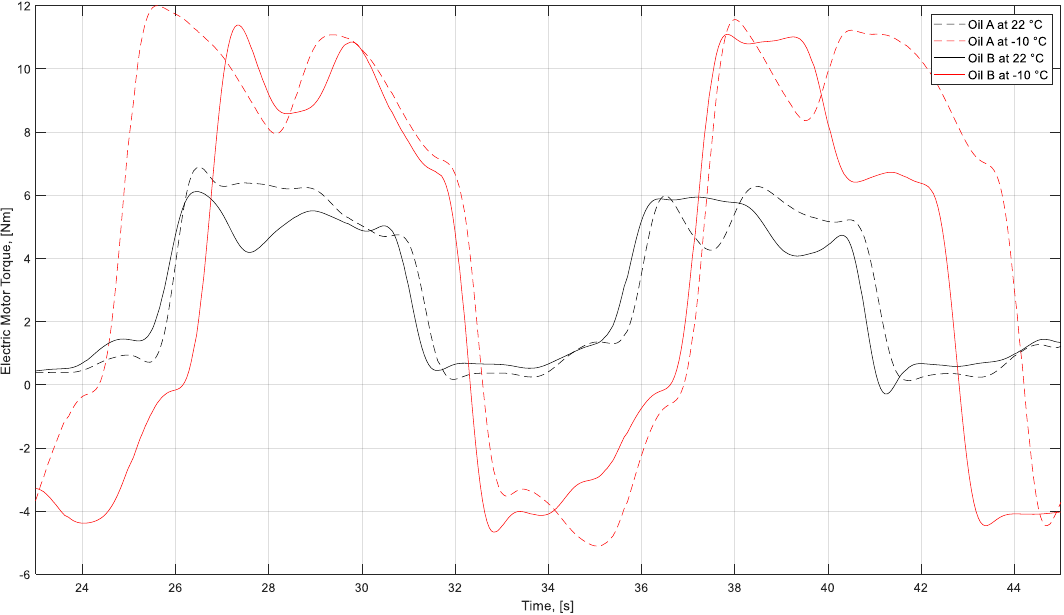
Figure 6. Example of electric motor torque with Oil A and Oil B at temperatures of 22 °C and − 10 °C with payload of 120kg and motor speed of 600 rpm.